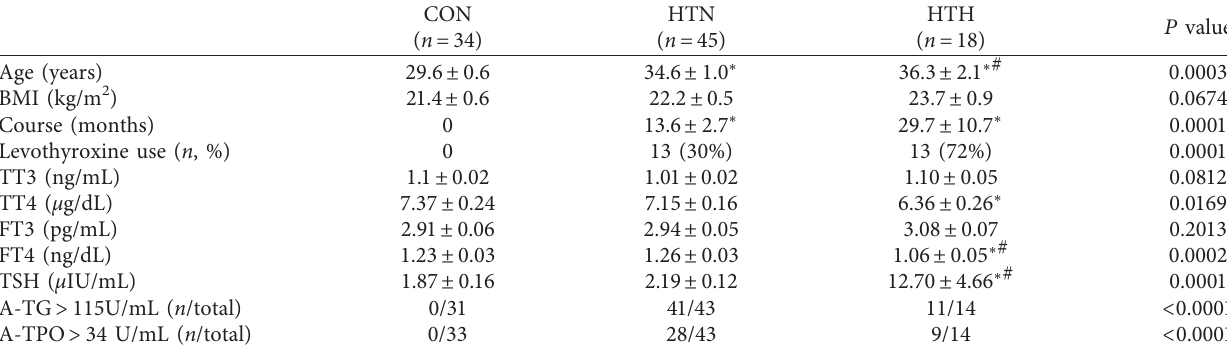
Table 1: The clinical characteristics of the